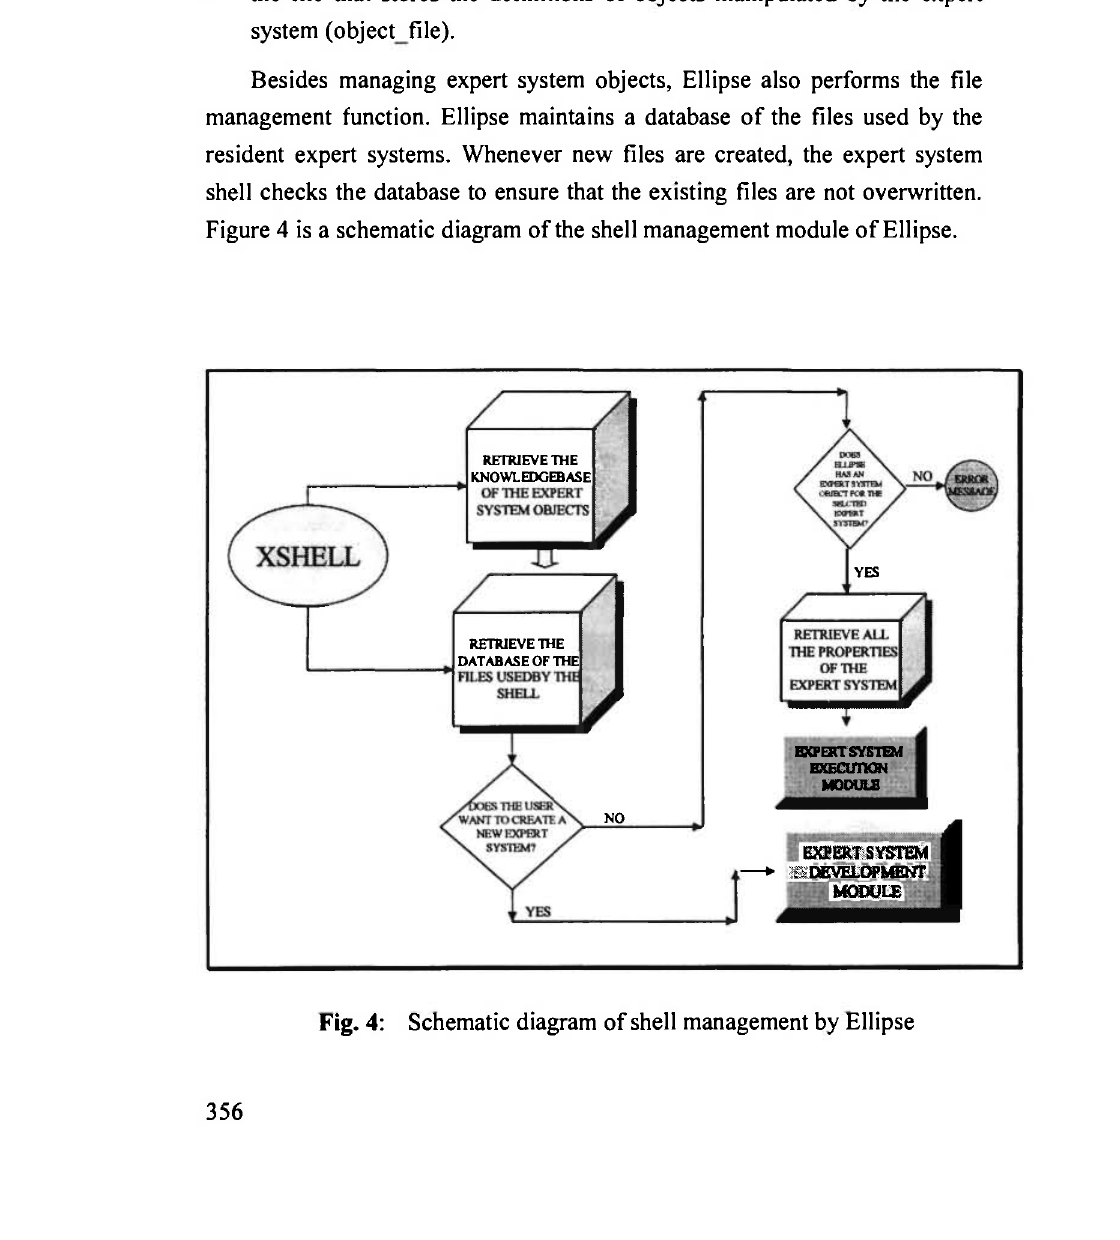
Fig. 4: Schematic diagram of shell management by